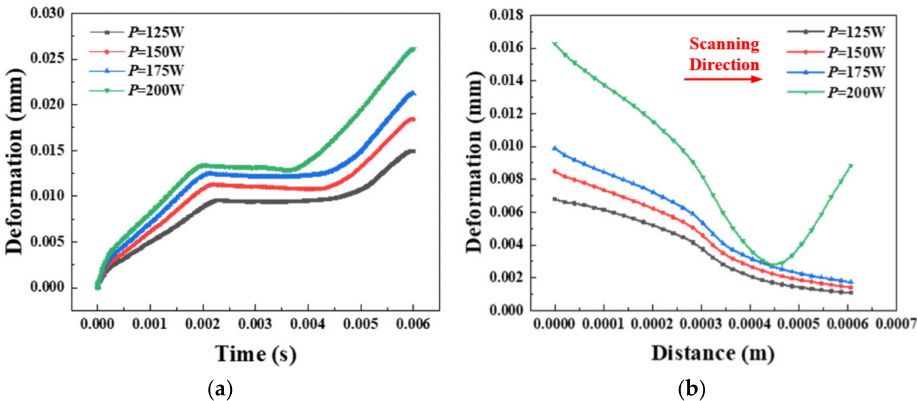
Figure 8. ( a ) Displacement deformation at different powers in the initial point of the midline. ( b ) Displacement deformation distribution under different powers at the same